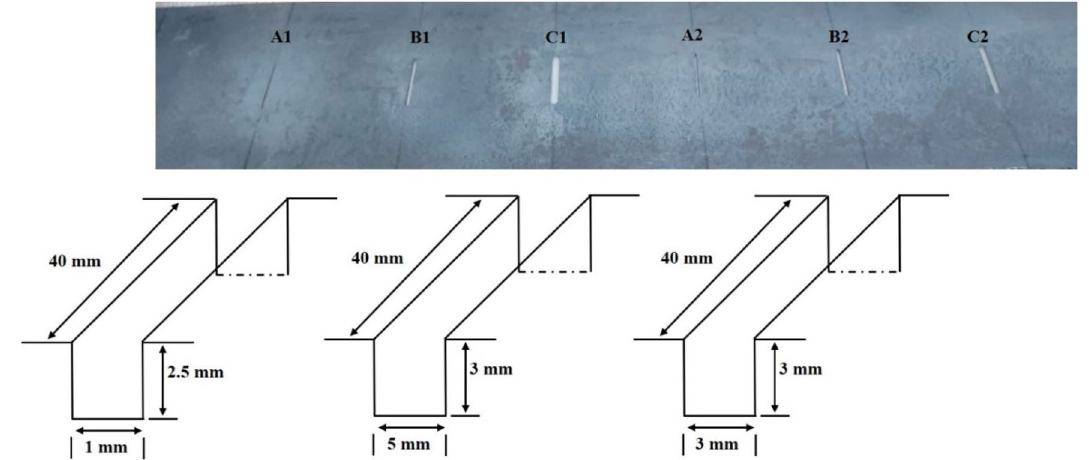
Fig. 3 Cuts made to the structure to emulate defects in the ferromagnetic plate